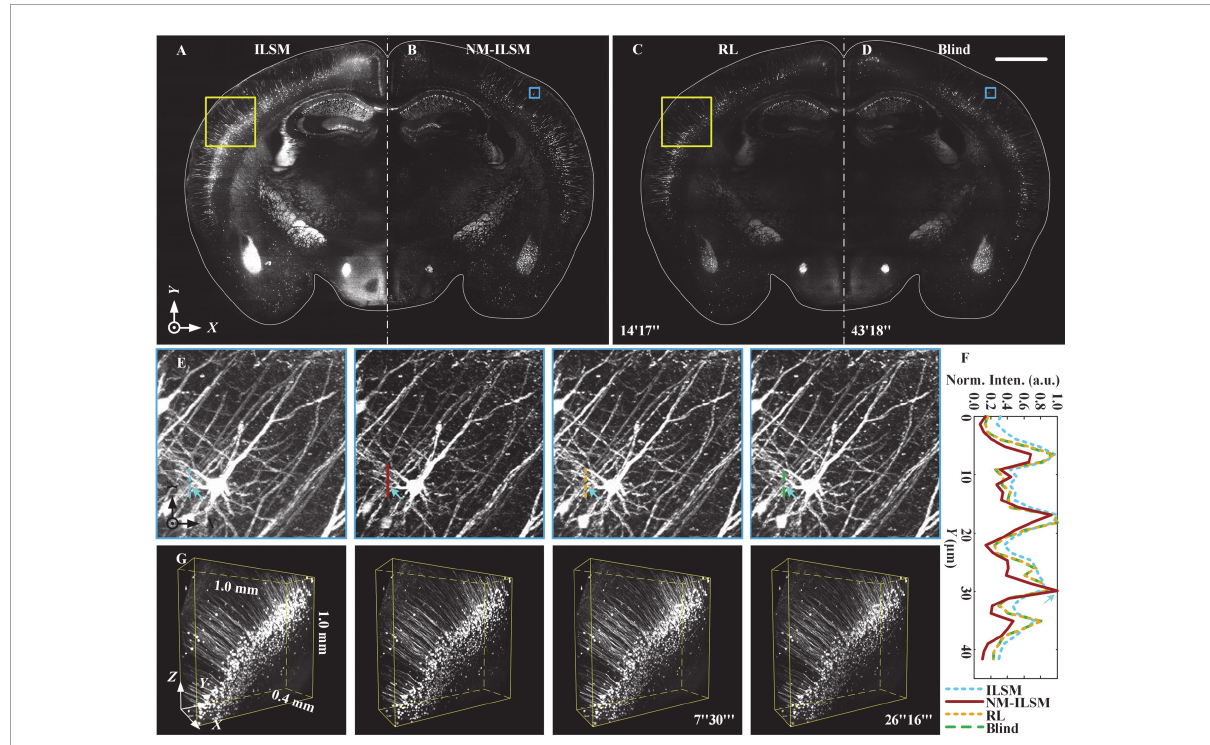
FIGURE6 Inverted light-sheet microscopy, NM-ILSM, RL deconvolution, and blind deconvolution 3D imaging quality comparison for thick brain tissue. (A–D) Normalized MIPs of a 20- µ m-thick coronal ( XY ) plane. Scale bar: 1 mm. (E) Normalized MIPs of a 200 × 200 × 144-pixel block in the blue boxes in (A–D) . (F) Normalized intensity profiles along the colored lines in (E) . (G) Three-dimensional visualization of volumes in the cortex indicated by the white boxes in (A–D)